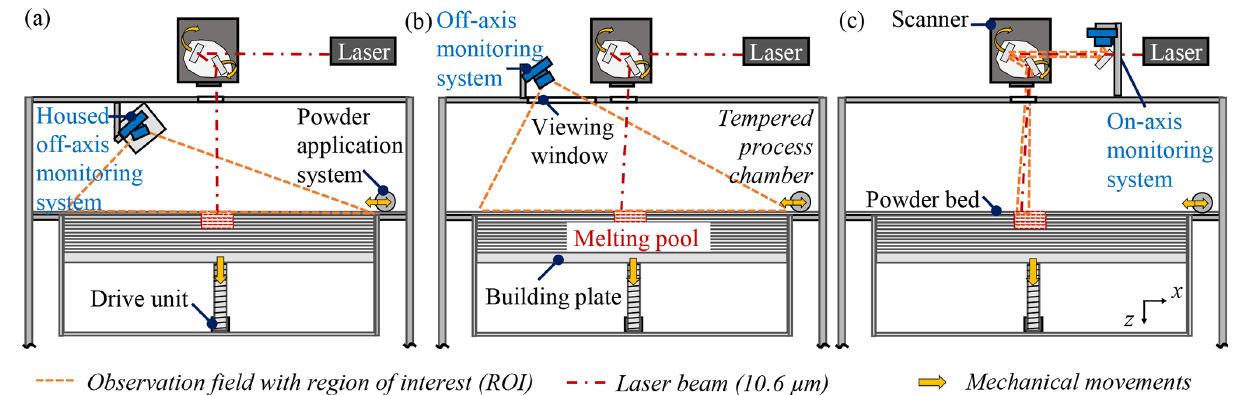
Figure 1. Positioning of optical monitoring systems (a) off-axis, inside, (b) off-axis, outside, and (c) on-axis, outside the process chamber (Lerchen et al.,